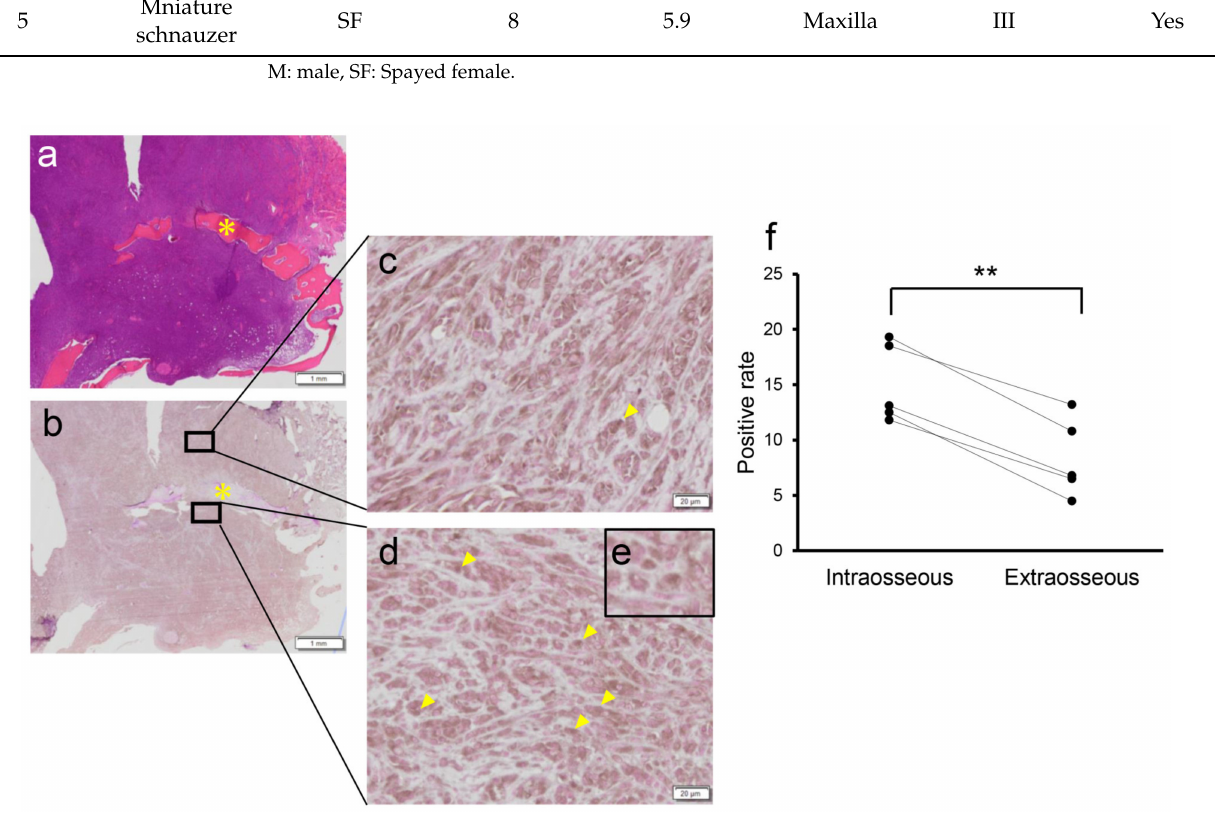
Figure 4. HIF-1 α expression analysis by immunohistochemistry in canine melanoma tissues collected by curative intent surgery. ( a , b ) Representative image of HE staining ( a ) and immunostaining ( b ) of sample #4; ( c ) A magnified image of the extraosseous region; ( d ) A magnified image of the intraosseous region. Arrowheads indicated positive staining of the nucleus; ( e ) The higher magnification image of HIF-1 α positive cell; ( f ) Comparison of HIF-1 α expression between the intraosseous and extraosseous regions in five melanoma tissues indicated in Table 3. Significant difference was observed between the groups in brackets. ** p < 0.01. Arrow heads indicated HIF-1 α positive cells. Bar; 20 µ